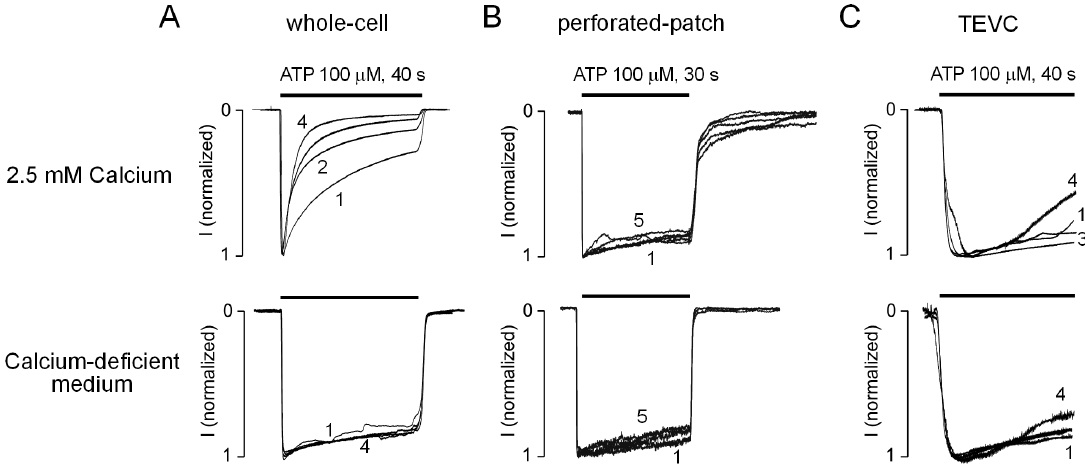
Figure 1. Dependence on recording conditions of the pattern of rat P2X2a receptor (P2X2aR) desensitization to repetitive ATP application. ( A ) Whole-cell recording in HEK293 cells. Traces of currents induced by repetitive application of 100 µ M ATP for 40 s with 4 min washout periods for cells bathed in calcium-containing medium (2.5 mM; top traces) or in calcium-deficient medium (0.09 mM calcium; bottom traces) at a holding potential of − 60 mV are shown. The progressive increase in the rates of receptor desensitization is termed use-dependent desensitization (UDD); ( B ) Perforated patch-clamp recording in HEK293 cells. Notice that there is no difference in the rate of receptor desensitization during repetitive agonist application (100 µ M ATP for 30 s with 4 min washing periods) in cells bathed in calcium-containing (top) or calcium-deficient (bottom) medium; ( C ) Two-electrode voltage clamp (TEVC) recording in Xenopus oocytes. The currents induced by four consecutive ATP applications in oocytes bathed in calcium-containing (top) or calcium-deficient (bottom) medium are shown. In ( A , C ), the data shown are normalized representative recordings. In all panels, traces shown are representative of at least five similar experiments. In this and the following figures, horizontal black bars indicate duration of ATP application, and the numbers indicate the order of each ATP